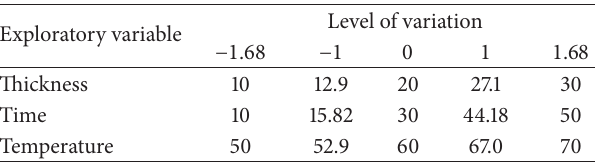
Table 9: Analysis of variance (ANOVA) for tomato mass loss during drying